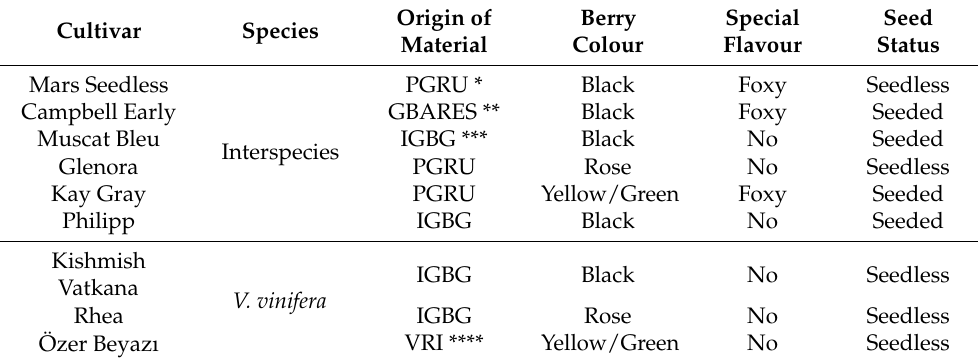
Table 1. Major characteristics and origins of grape cultivars used in this